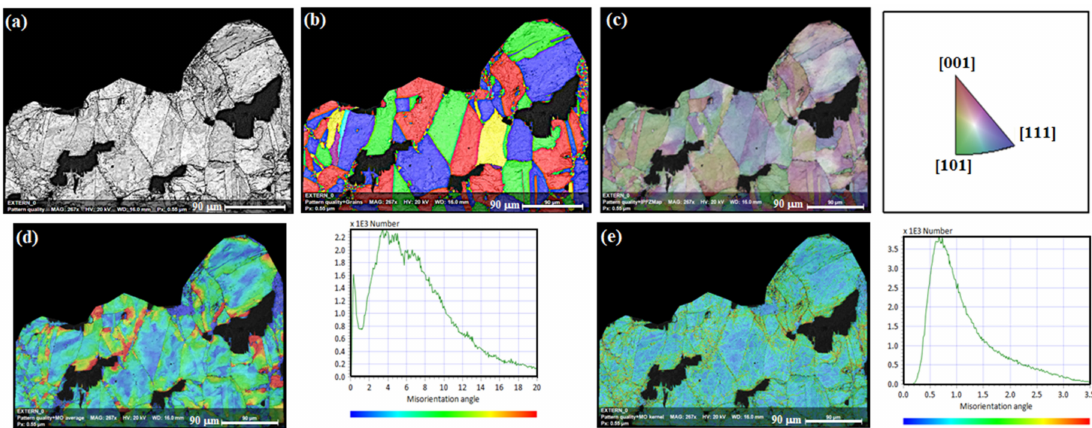
Figure 6. EBSD analysis on specimen (heat-treated at 1200 ◦ C) after creep test at 800 ◦ C under 100 MPa stresses; ( a ) pattern quality (PQ) map, ( b ) pattern quality grains map, ( c ) inverse pole figure (IPF) map, ( d ) grain average misorientation (GAM) map and ( e ) kernel average misorientation (KAM)